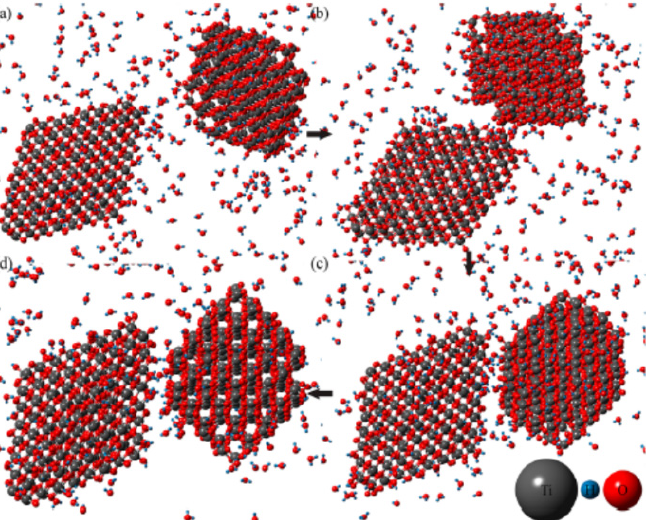
Figure 8. Snapshots of the results of molecular dynamics simulation for oriented attachment of TiO 2 nanocrystals in the presence of water vapor These snapshots were taken at ( a ) 187.5 ps, ( b ) 205 ps, ( c ) 212.5 ps, and ( d ) 225 ps. Reprinted with permission from Ref. [128]. Copyright 2014, the American Chemical Society.